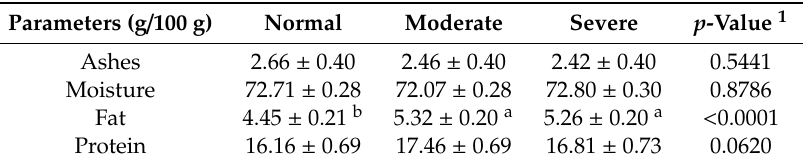
Table 5. Mean values of moisture, fat and protein of hamburgers produced with chicken breast of Ross broiler chickens (AP95) without myopathies and a ff ected by wooden breast myopathy. Parameters (g / 100